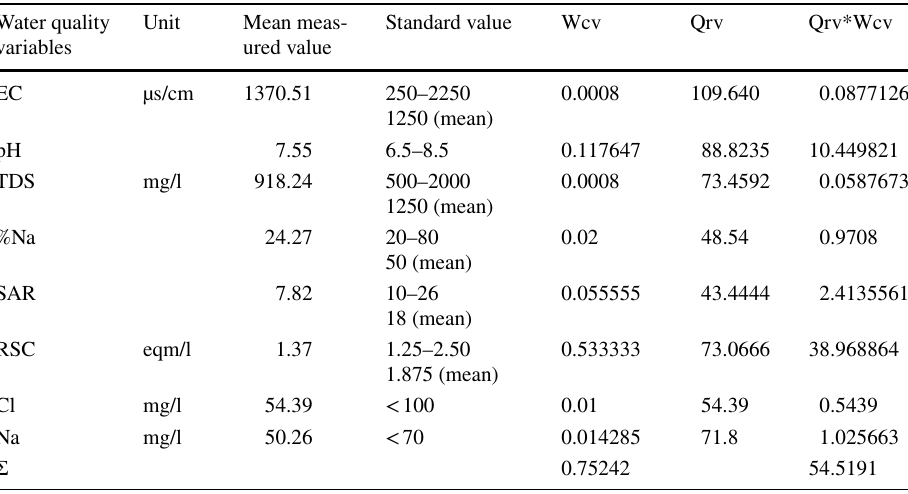
Table 6 Water quality relative weight and quality rating values of water sample no.